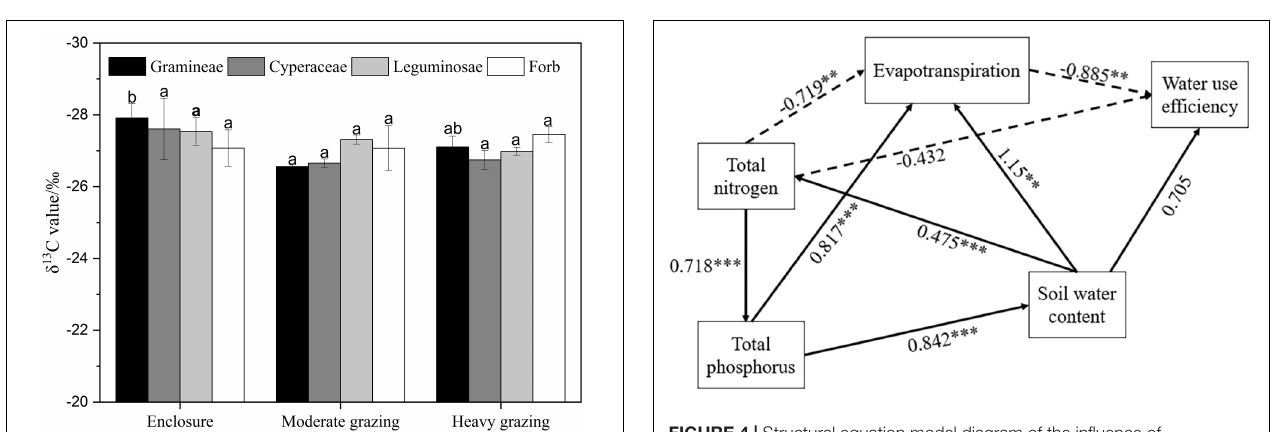
FIGURE 4 | Structural equation model diagram of the influence of environmental factors on plant water use efficiency. The solid line and the dashed line represent the positive and negative correlations, respectively, and the value on the arrow is the standard path coefficient. Data whose absolute value is < 0.1 are not shown in the figure. ∗∗ indicates P < 0.01 and ∗∗∗ indicates P <